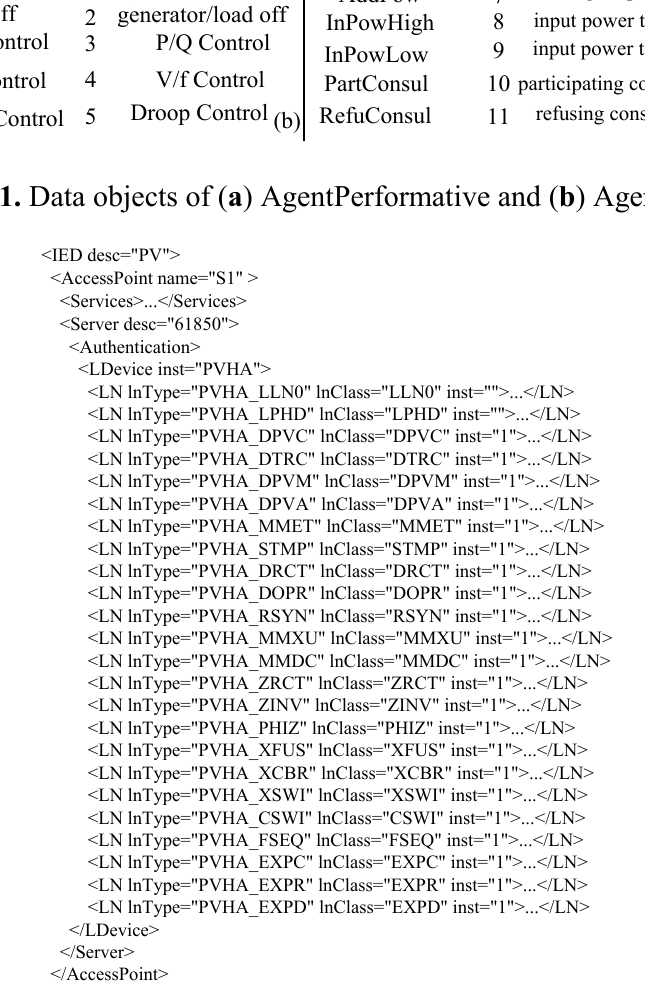
Figure A2. Substation configuration language description of PVHA in